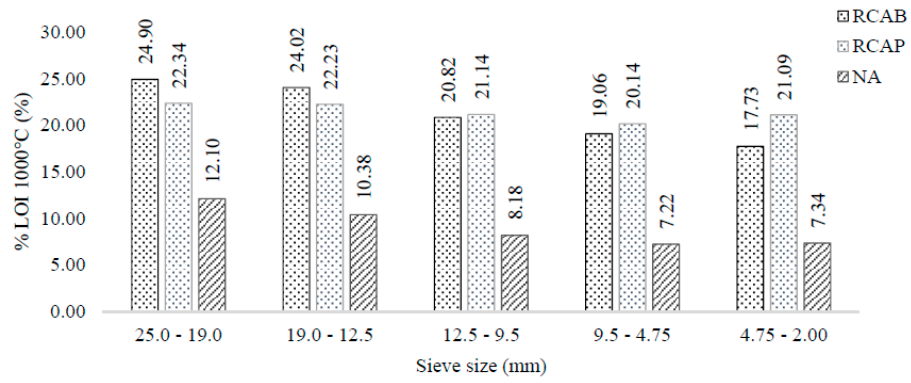
◦ C of NA, RCAP, and RCAB by size. Figure 7. LOI 1000 °C of NA, RCAP, and RCAB by size. Figure 7. LOI 1000